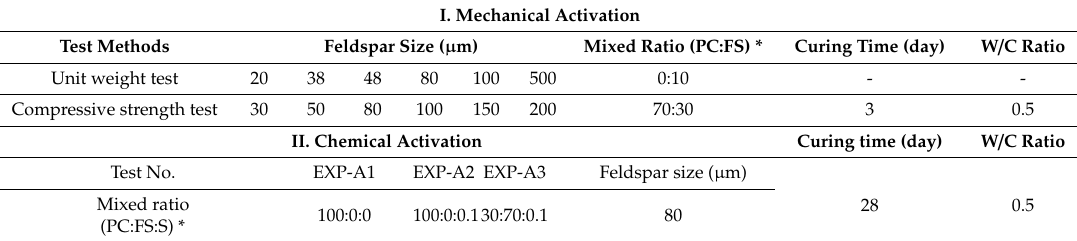
Table 4. Test conditions for activation methods (mechanical and chemical activation).